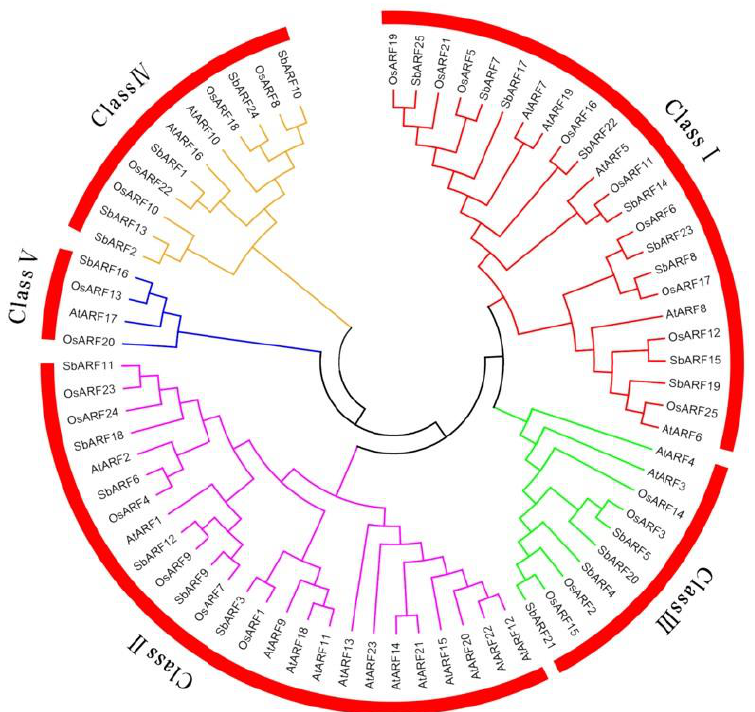
Figure 1. Phylogenetic analysis of ARF in Sorghum bicolor , Oryza sativa and Arabidopsis . The NJ tree shows that the ARFs of Sorghum bicolor (25), Oryza sativa (25), and Arabidopsis (23) were clustered into five classes (I–V). Class I, II, III, IV, and V are marked with red, fuchsia, green, yellow, and blue lines, respectively.